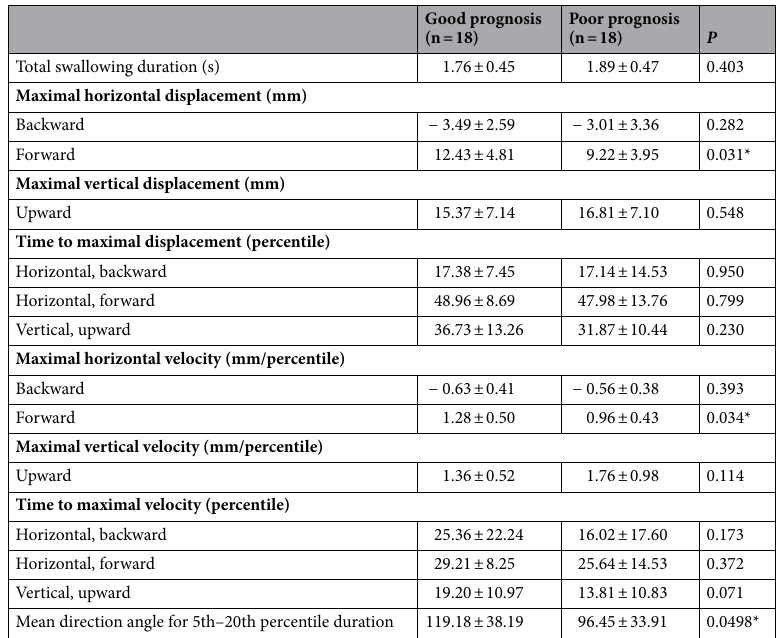
Table 2. Results of analysis for the maximal and mean kinematic parameters of hyoid motion in age- and sex-matched stroke patients with good and poor prognosis (n = 36). Values are presented as mean ± standard deviation. * P -value <